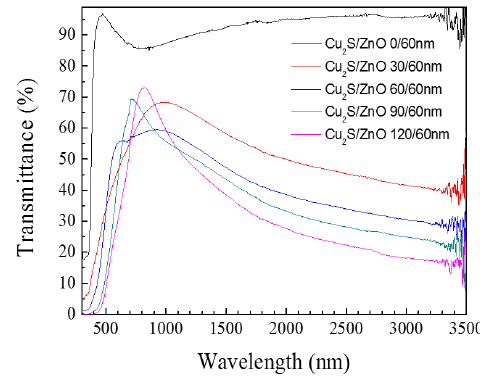
Figure 9. The transmittance diagram of Cu 2 S/ZnO/glass complex films for different thickness.